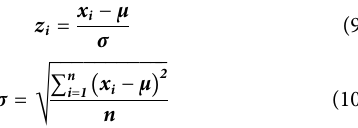
(Figure 4C). In terms of changes, Daxiangling and the Minshan Mountains had the largest growth rate of nighttime light area (3426.05% and 2463.24% respectively) from 2000 to